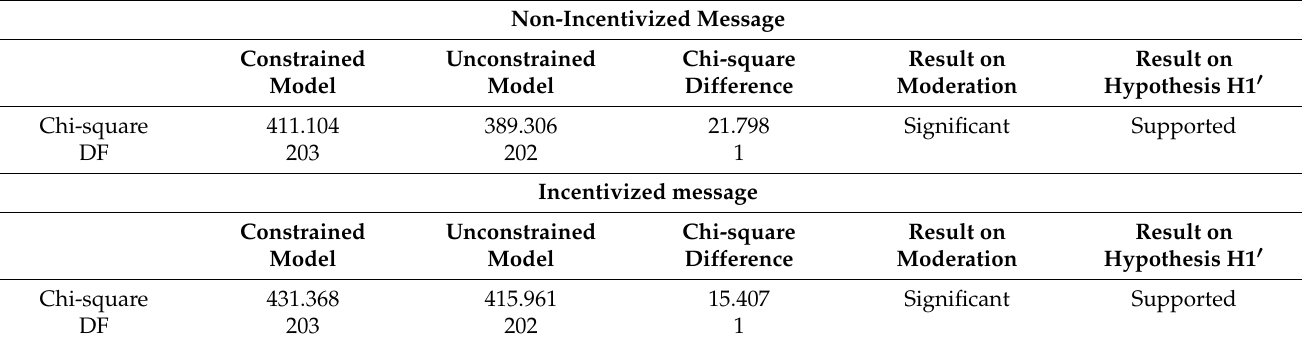
Table 6. Moderation test of the message type in the relationship between perceived argument quality and message credibility.